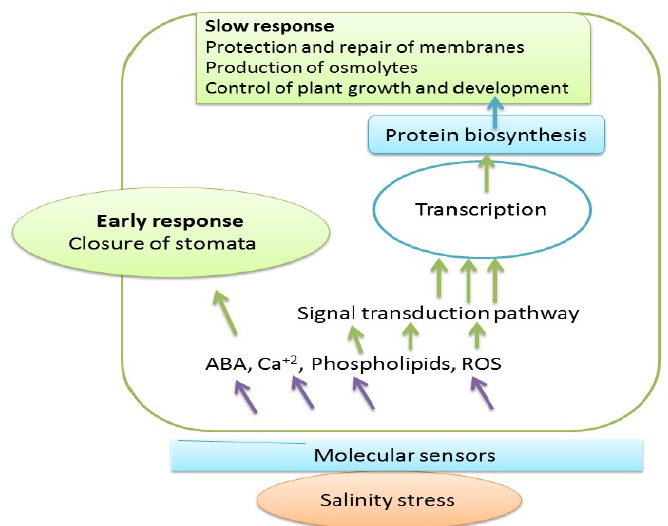
Figure 3. A simple representation of plant signal transduction pathways in response to salinity stress. Different phytohormones and molecular sensors are activated in response to salinity stress. For instance, phytohormones, i.e., ABA, are signal molecules in plants, transducing the quick response to salt stress and closing plant stomata. Biosynthesis of molecules through transcription, on the other hand, is a slow, much slower process.